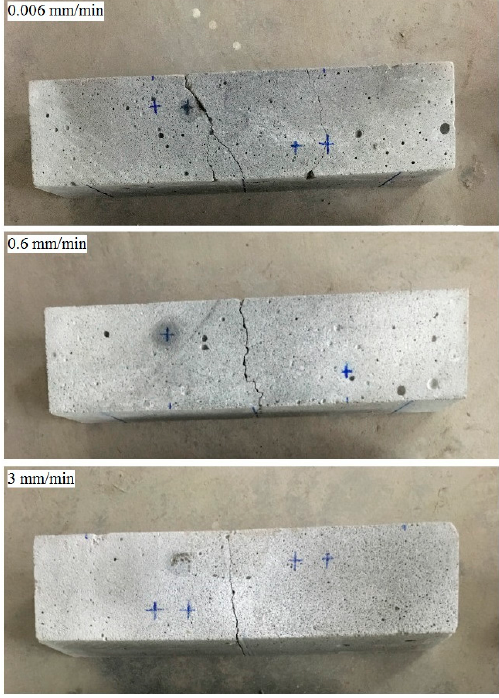
Figure 15. The failure mode of foamed concrete at different loading rates.